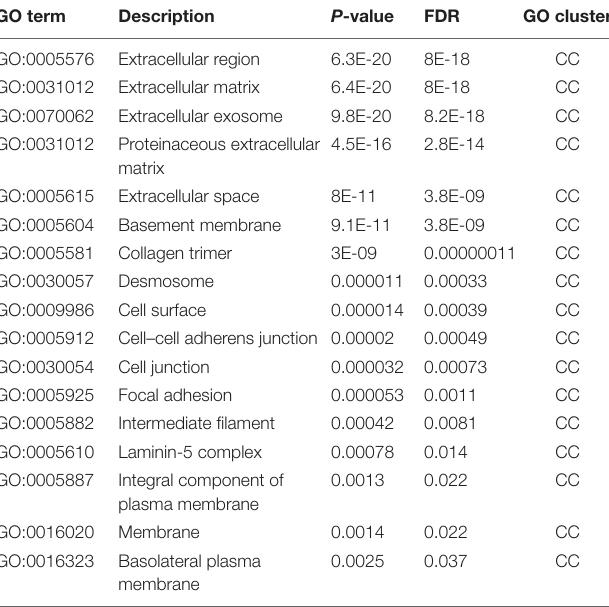
TABLE 4 | Gene ontology enrichment results, cellular components (CC).